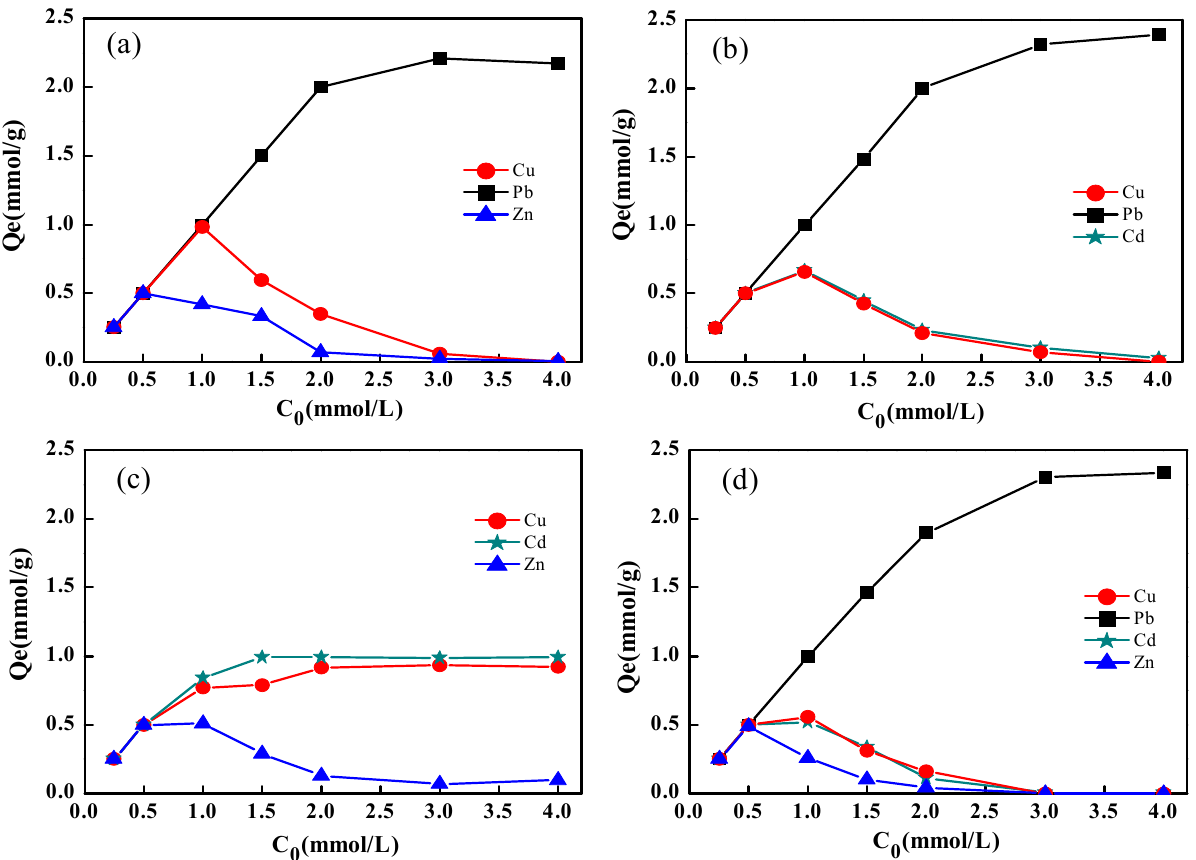
Figure 5. Adsorption capacity of NaX for heavy metal ions present in ternary and quaternary systems: ( a ) Pb 2+ -Cu 2+ -Zn 2+ , ( b ) Pb 2+ -Cd 2+ -Cu 2+ , ( c ) Cd 2+ -Cu 2+ -Zn 2+ and ( d ) Pb 2+ -Cd 2+ -Cu 2+ -Zn 2+ .